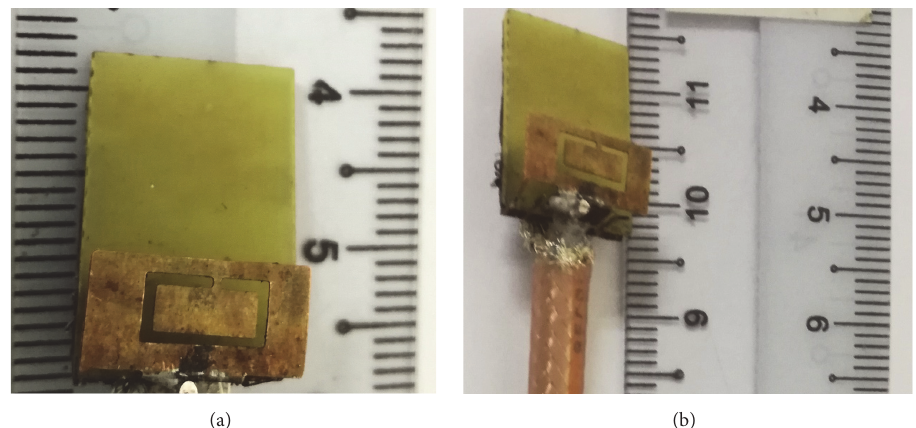
Figure 2: Fabricated SRR based PIFA for measurements. (a) Top view; (b) 3D view.